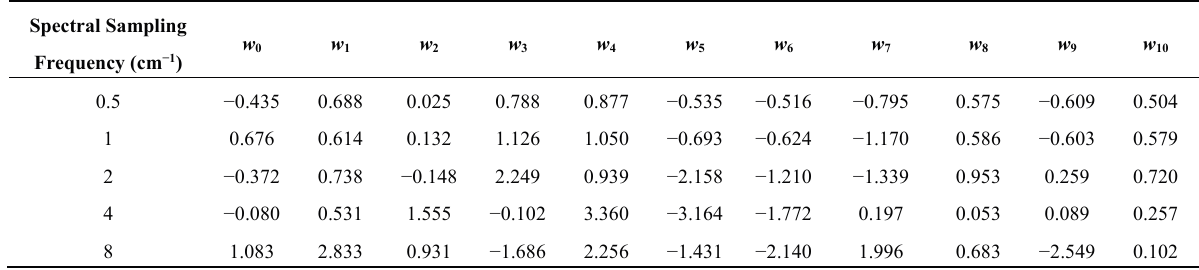
Table 1. The coefficients w i refitted for each spectral sampling frequency using linear regression with simulation